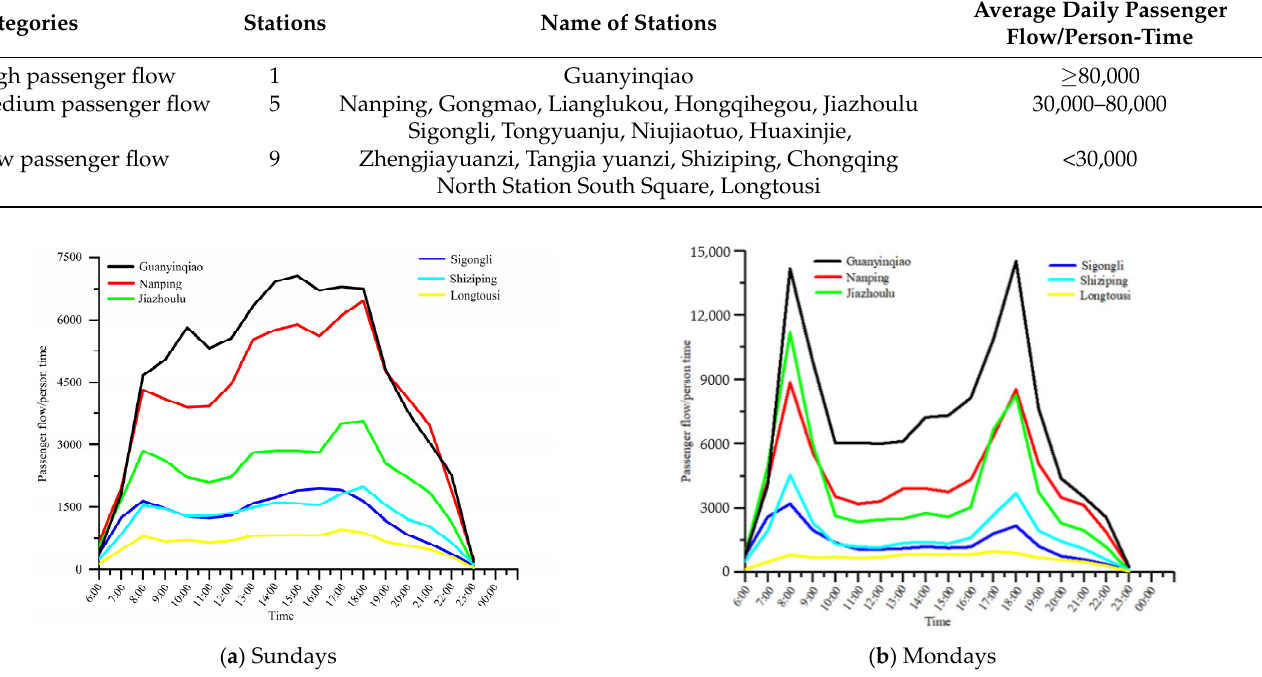
Figure 8. Distribution characteristics of passenger flow on weekdays and non-weekdays at different stations over time.